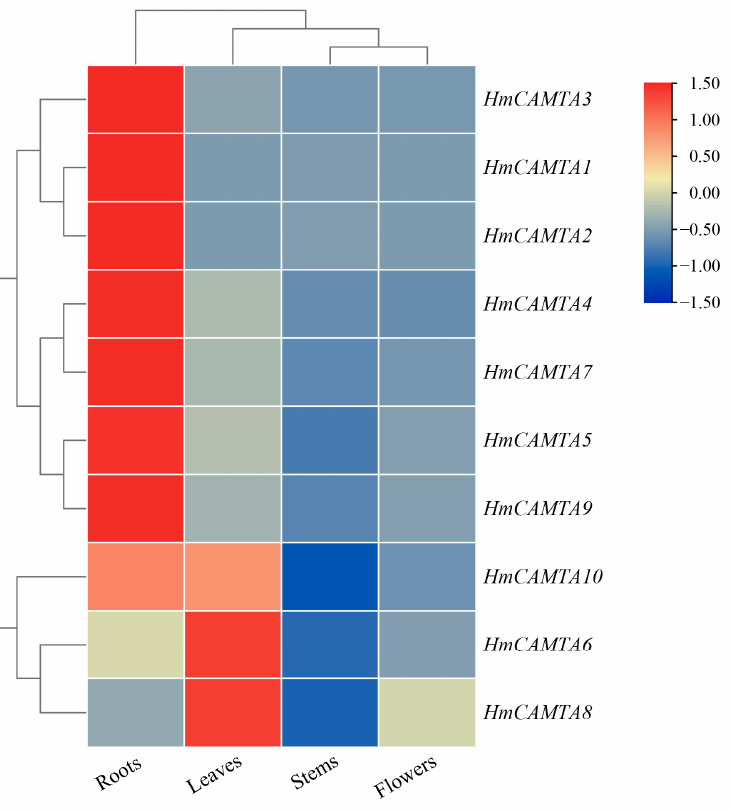
Figure 8. Heatmap analysis of HmCAMTA genes expression in different tissues. After homogeniza- tion, the value of expression appears in the heatmap, with red representing high expression and blue representing low expression.